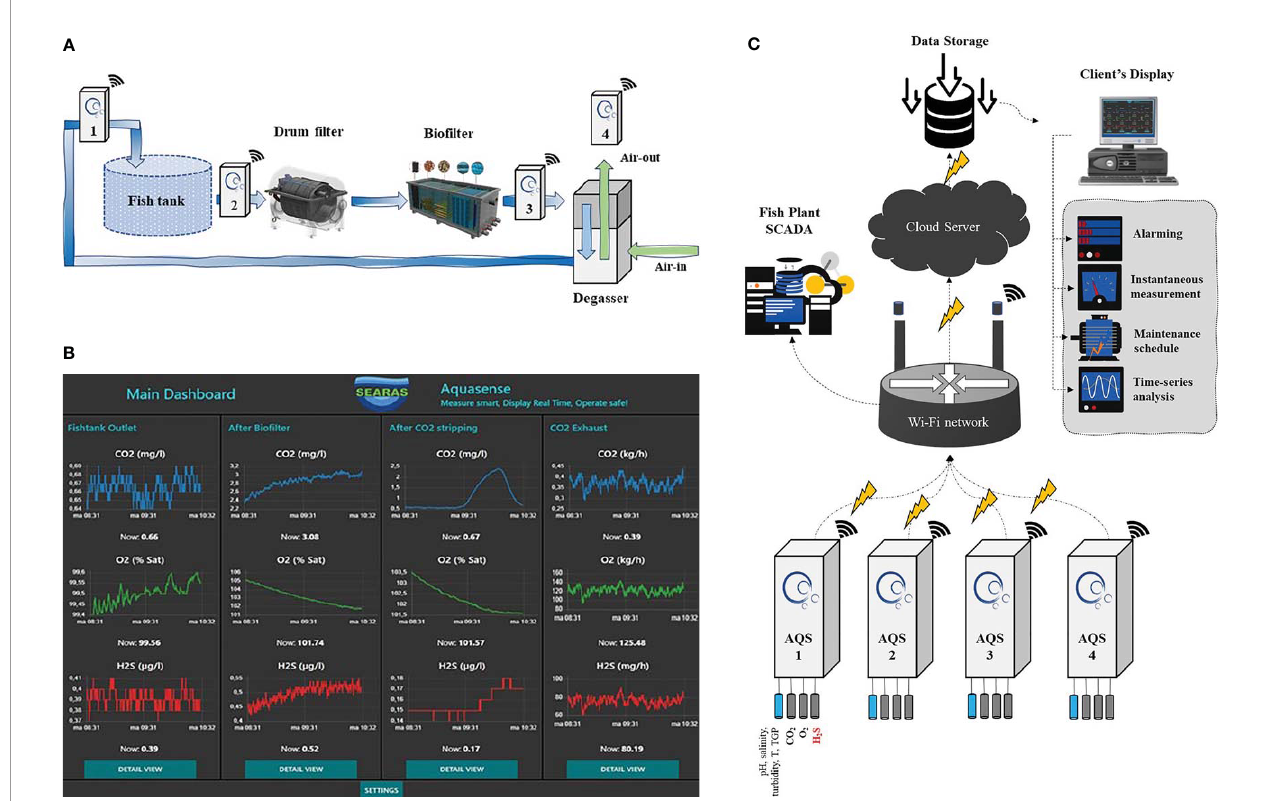
FIGURE 2 | (A) AQS consists of four units per RAS that are setup in four potential hotspots: 1) before the fi sh tank, 2) after the fi sh tank and before the drum fi lter, 3) after bio fi lter and 4) after degasser. (B) Example of installed AQS in RAS, and the main dashboard to present time-series of real-time monitored data for water quality parameters like O 2 , CO 2 and H 2 S as presented in panel (A) . (C) Data fl ow schematic diagram of